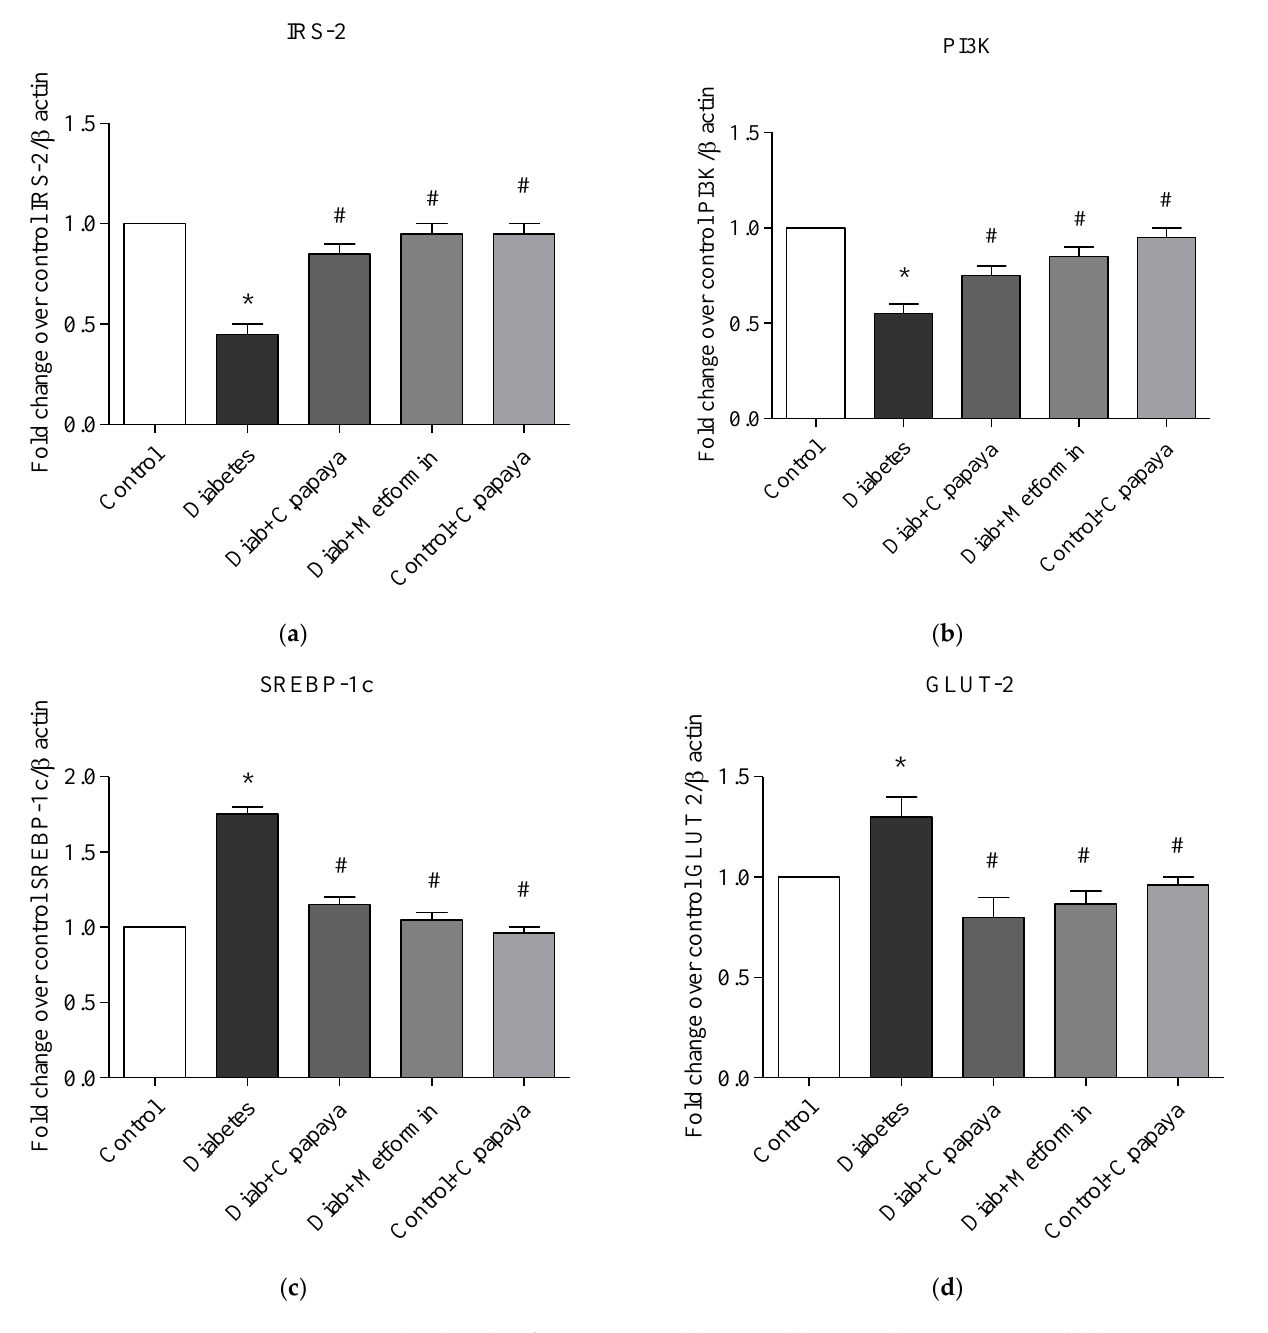
Figure 8. ( a – d ) Role of C. papaya on ( a ) IRS-2, ( b ) PI3K, ( c ) SREBP-1c, and ( d ) GLUT-2 mRNA expression levels. p < 0.05 was considered statistically significant among the groups: *-control;